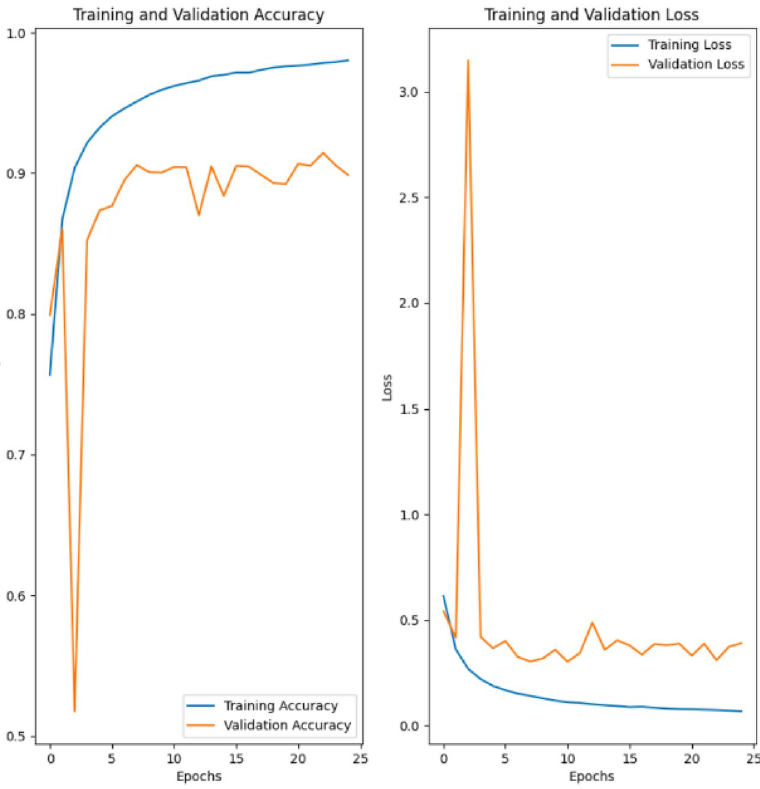
Figure 6. Accuracy and loss in the training and validation data sets of a CNN to identify the four phases of abdominal CT scans.